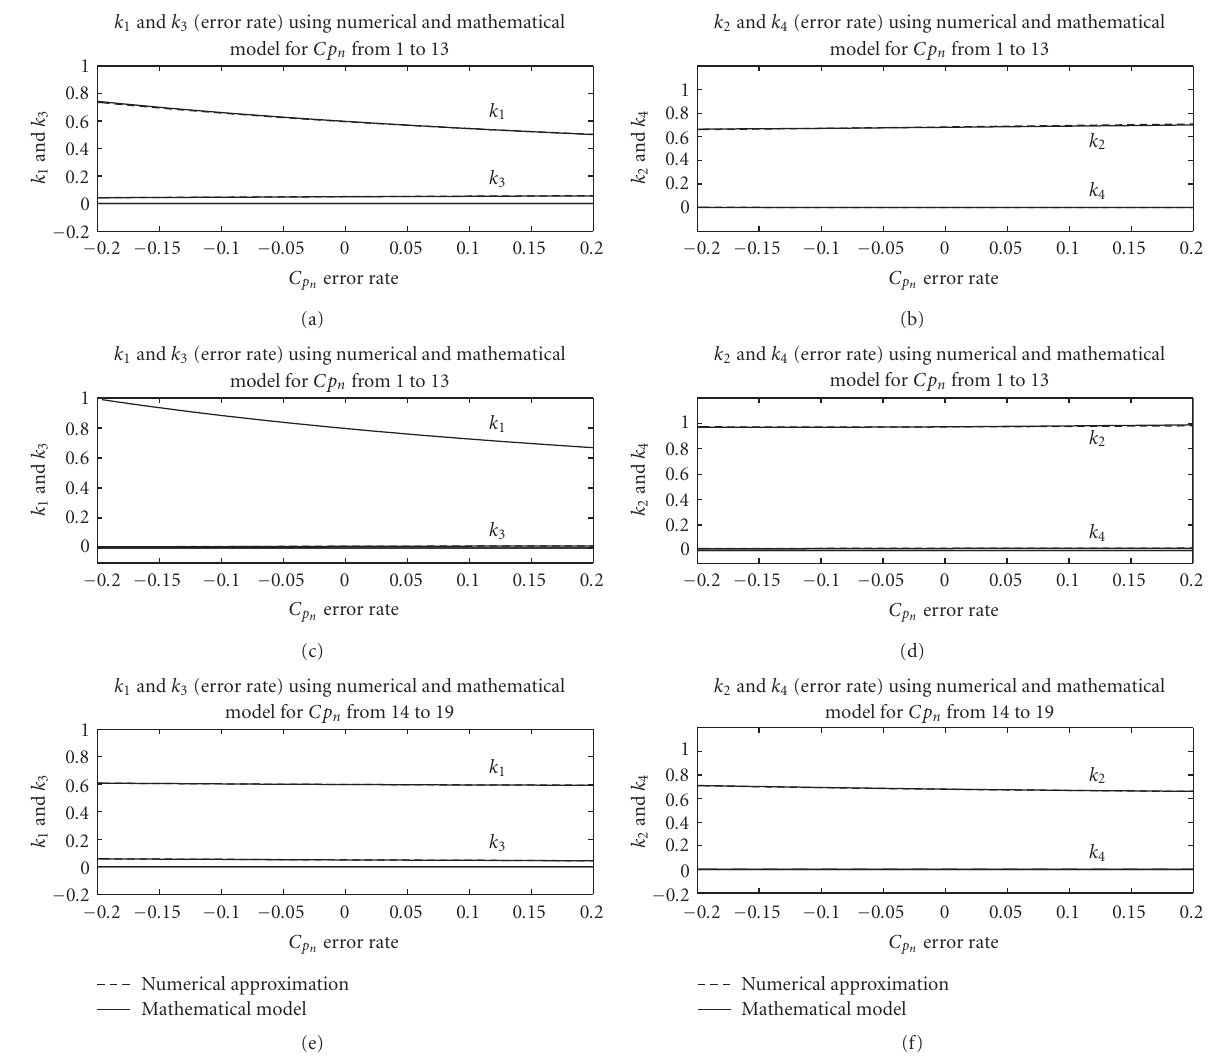
Figure 6: Comparison between the estimated k 1 , k 2 , k 3 , and k 4 of liver using the derived expressions and numerical approximation for a range of erroneous blood functions. Top two figures show results when all samples of the blood are erroneous, (a,b)/(c,d) when the initial peak is erroneous, and (e,f) when the tail part is